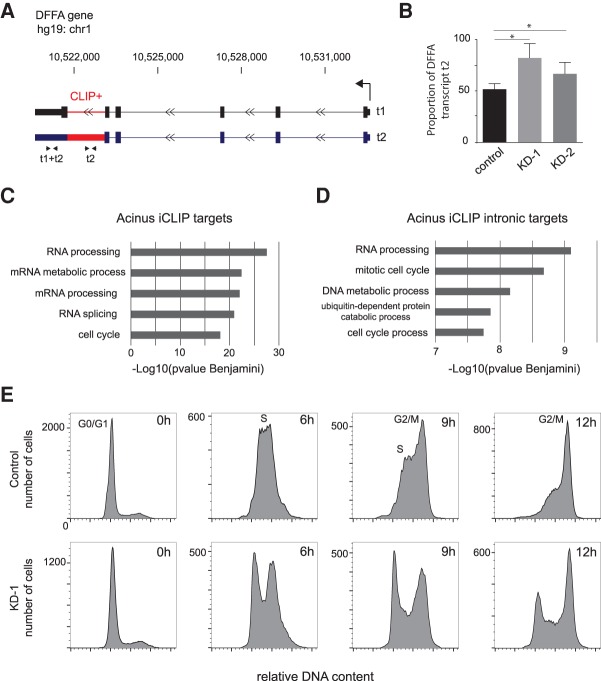
Acinus regulates intron retention in the DFFA pre-mRNA, which encodes an apoptotic regulator, as well as of pre-mRNAs encoding RNA processing factors and cell cycle regulators. (A) Structure of DFFA transcripts. The transcription start site and the direction of transcription are indicated by an arrow. The CLIP+ intron (retained in transcript 2) is indicated in red. Arrows underneath indicate primers used for RT-qPCR analysis to detect specifically transcript 2 or both transcripts t1 and t2. (B) Ratio of DFFA transcript 2 compared to total DFFA transcript. The quantification of transcript 2 and total transcript was done by RT-qPCR using specific primers. The quantification was done on four replicates for control cells and five replicates for knockdown 1 and 2 of Acinus. (*) P-value below 0.05 as calculated using the Mann-Whitney test. (C) Graph showing selected enriched GO terms for genes bound by Acinus (4416 genes). This analysis was done using DAVID functional annotation tool and ranked using the Benjamini corrected P-value. (D) Graph showing selected enriched GO term for genes that show binding of Acinus in introns (2668 genes). This analysis was done using DAVID functional annotation tool, as described above. (E) Cell cycle profile of control and Acinus-depleted HeLa cells following release from a G1 arrest at 0, 6, 9, and 12 h. After siRNA treatment, cells were arrested in G1 using 2 mM mimosime treatment for 20 h. After release, cells were collected at different time points. The cell cycle profile was obtained by propidium iodide staining and flow cytometry.